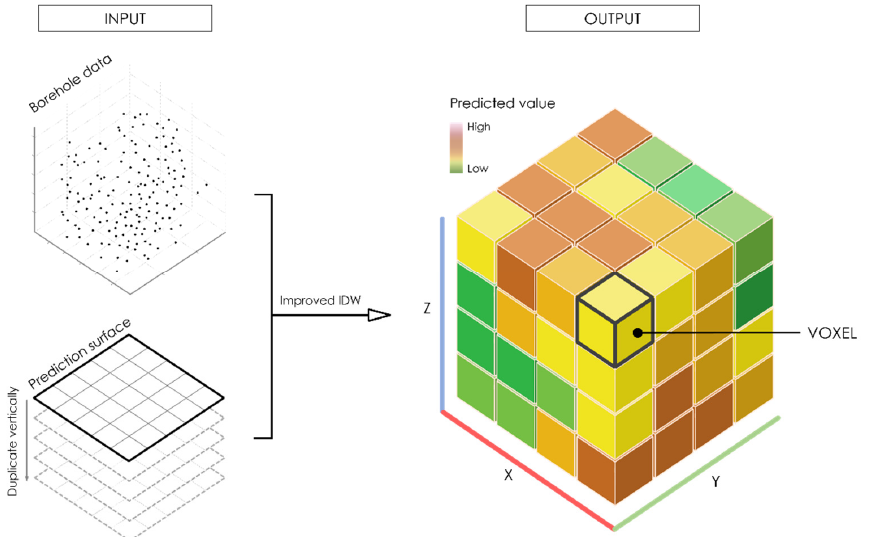
Figure 6. Conceptual diagram of improved IDW results mapping.